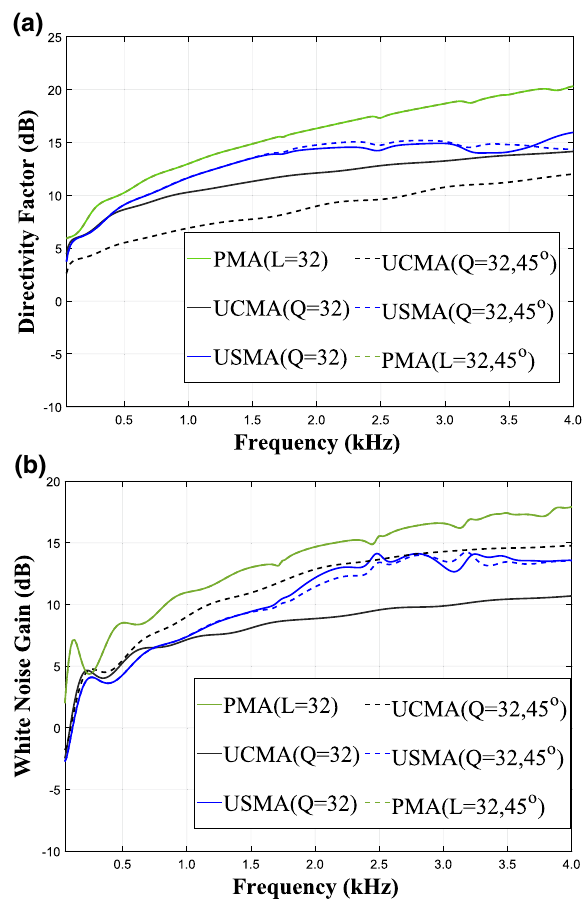
Fig. 6 a The DF and b the WNG of the PMA, USMA and UCMA geometries with Q = L = 32 for two sources located at X-axis and θ s = φ s = 45